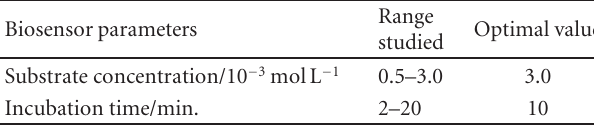
Table 2: Optimization of CNTs-AChE biosensor